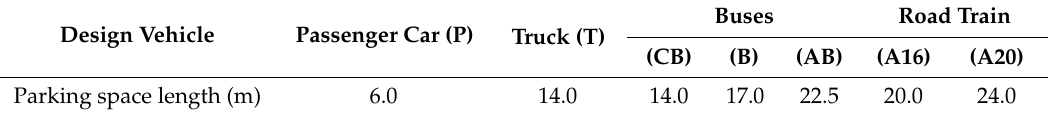
Figure 12. Possible layouts of the parking space: ( a ) two-side parking; ( b ) one-side parking; a—the depth of the parking space; b—the width of the passage between the rows of parking spaces; c—the distance occupied by the strip for parking and manoeuvring; d—the distance occupied by the strip for parking and travel; e—security band; f—manoeuvring strip; g—the width of the parking place; h—the width of the parking module; i—mark-up line length. Table 4. The length of parking spaces for longitudinal design